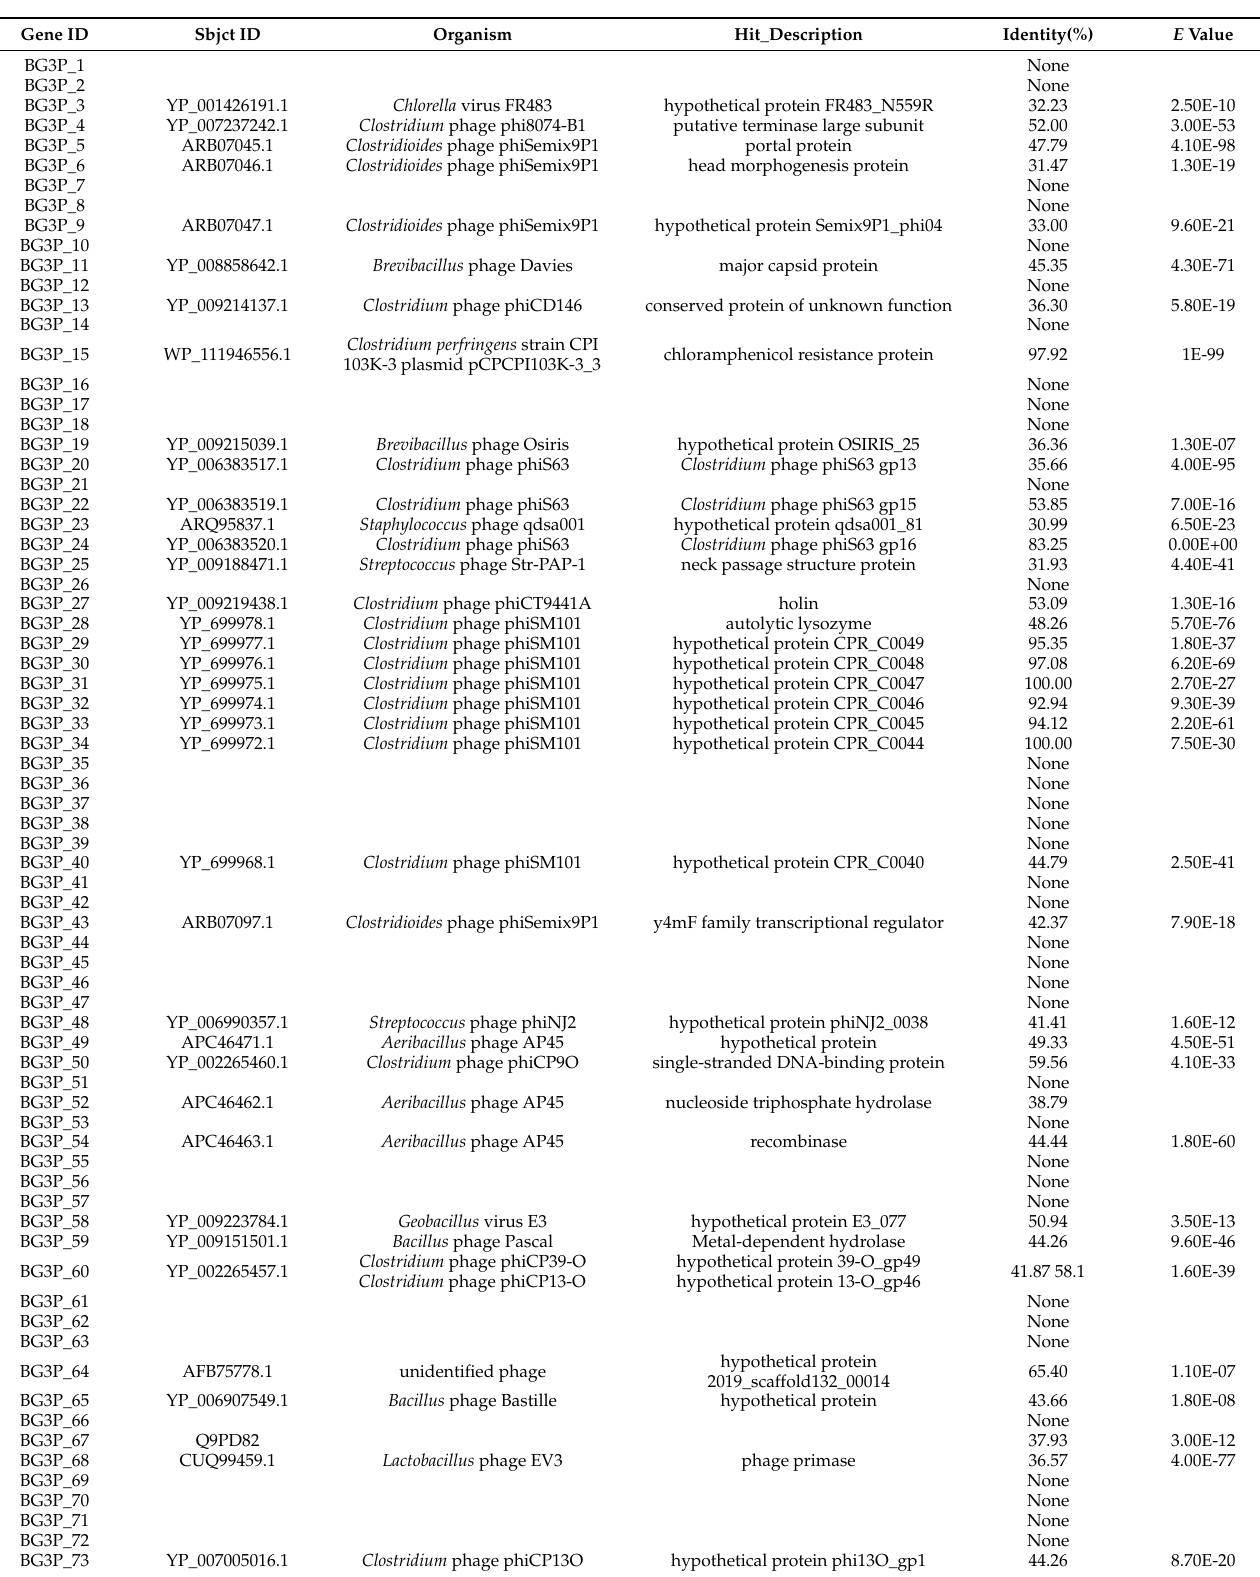
Table 4. Functional grouping of predicted orfs in phage BG3P and their similarity with